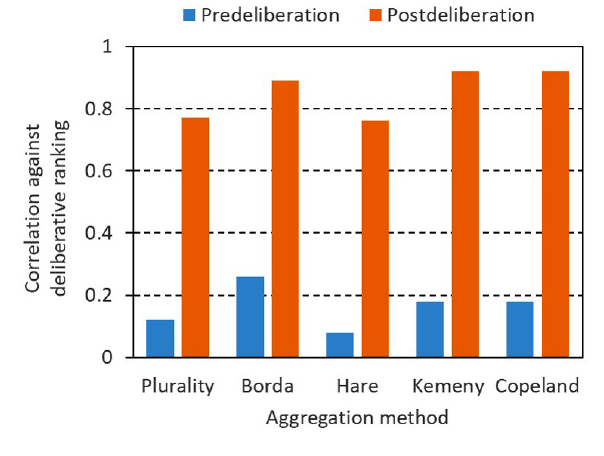
Fig. 3 . Bar plot of Kendall correlations between deliberative group rankings and aggregated individual rankings assessed before and after the deliberation. Correlations shown are the averages across